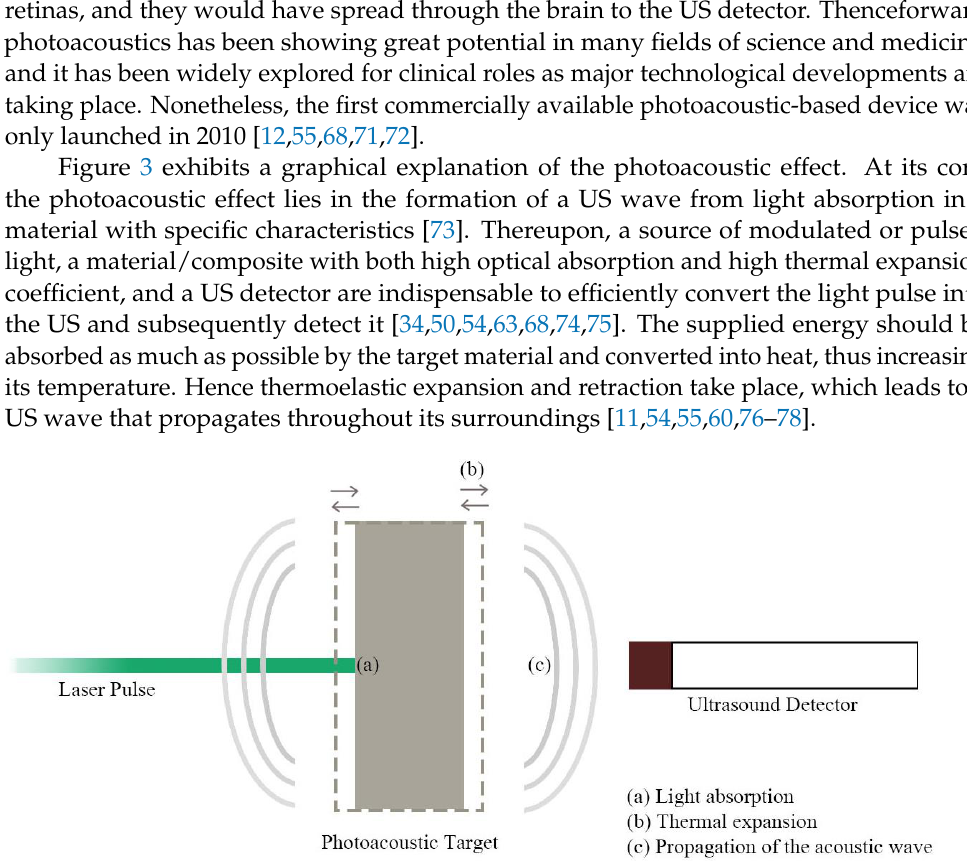
Figure 3. Schematic representation of the photoacoustics effect.